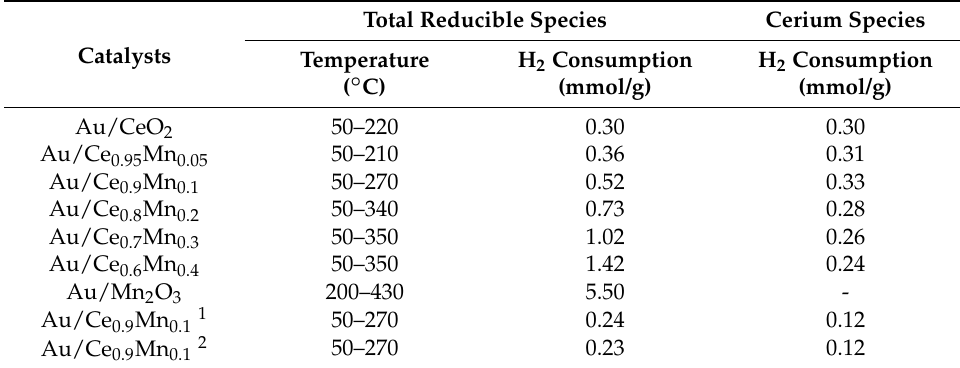
Figure 4. TPR profiles of Ce 1 − x Mn x O 2 − δ -supported Au catalysts with different Mn/Ce ratios. Table 2. H 2 -TPR results of the Au-supported catalysts